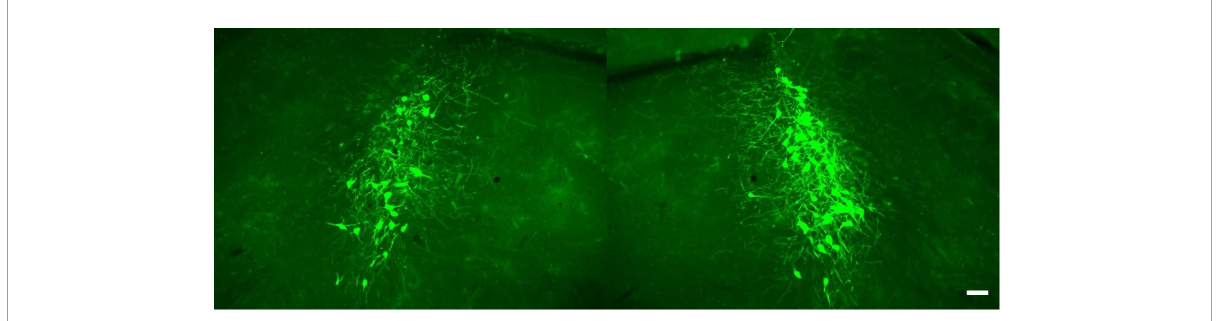
FIGURE6 EGFP + NE-containing cells in the ipsi- (at right ) and contralateral (at left ) LC nucleus following unilateral injection of retrogradely transported viral vector in the cerebellar medial nuc, scale bar = 100 µ m.